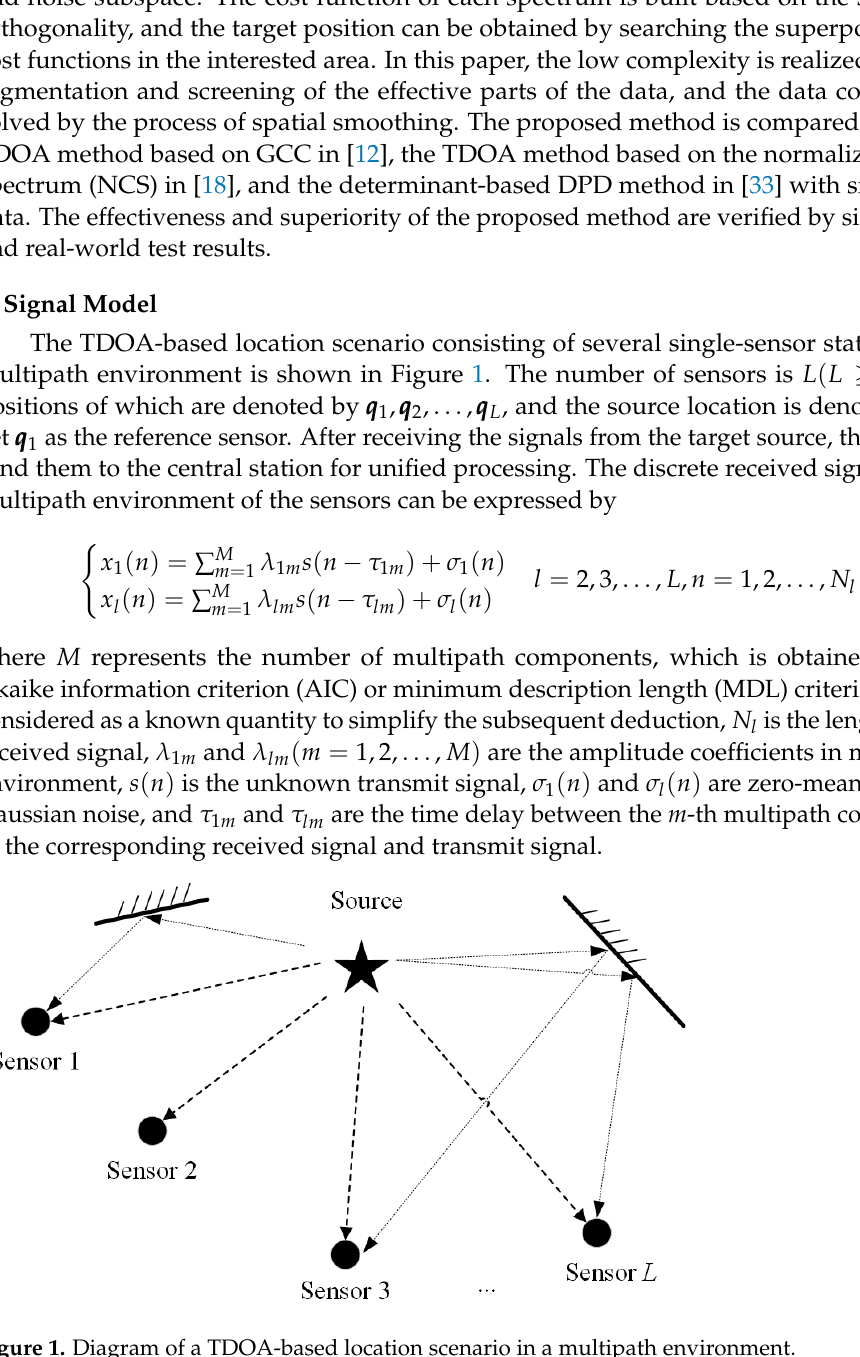
Figure 1. Diagram of a TDOA-based location scenario in a multipath